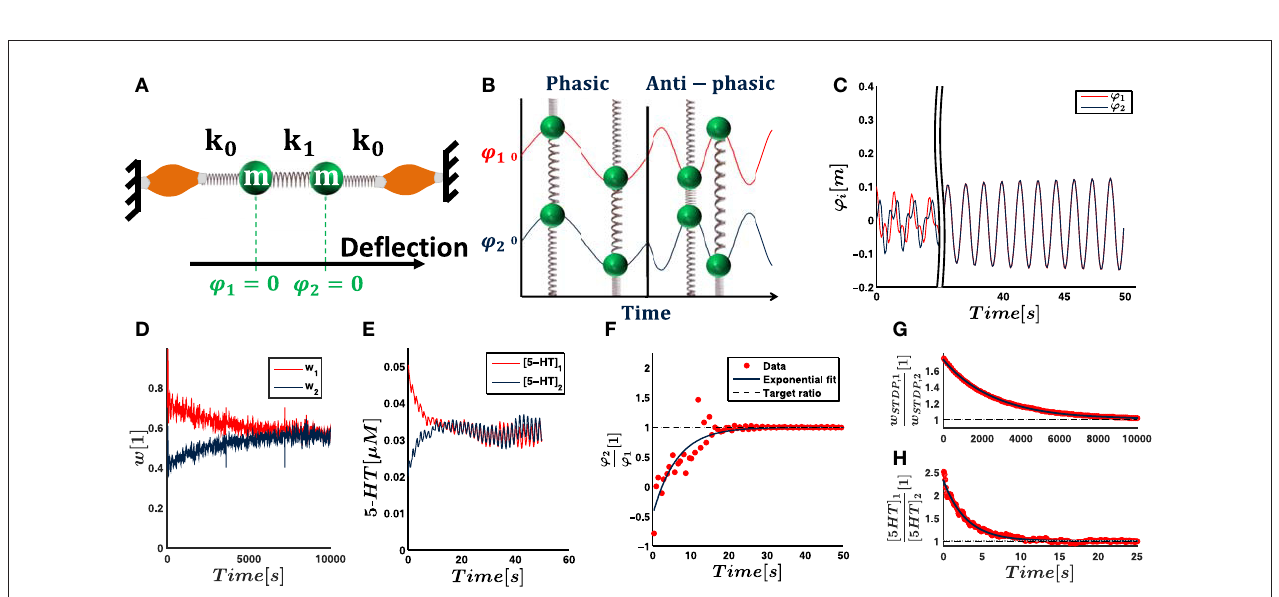
FIGURE 5 | The neural network as described in Figure 4 is initially supposed to control a simple mechanical system. (A) Two masses m are connected by springs of stiffness k 0 and k 1 and driven by muscles that can stretch the springs. Zero positions are given by the equilibrium positions when no force is applied. The deviations of the masses from their zero positions are used as joint deflections ϕ i . The neural network as described in Figure 4 controls the muscles’ forces. (B) The system has analytically known resonance modes of (1 , 1) T and ( − 1 , 1) T , i.e., the masses either oscillate in phase or anti-phasic. The task of our controller is to excite the system along any of the two eigenmodes with corresponding respective eigenfrequency. The other eigenmode decays due to friction. The final movement is thus resonant. (C) The deflection trajectories of both joints align and show phasic resonant movement after few seconds. (D) shows that the input weights, which are subject to STDP, converge toward the same value within hours. They therefore also align with the phasic resonance mode (1 , 1) T of the mechanical system. (E) shows that the 5-HT concentration within both motoneuron pools, and hence the output weights, converge toward the same value within seconds. (F) The alignment of the trajectories is illustrated by the deflection ratio ϕ 2 /ϕ 1 at peak positions of mass m 1 . Shown here is the time evolution of this ratio and an exponential fit. (G,H) The ratio of the synaptic and neuromodulatory weights converge to unity with different time scales, as illustrated by respective exponential fits. (All results illustrate the simulation with non-random initial weights).